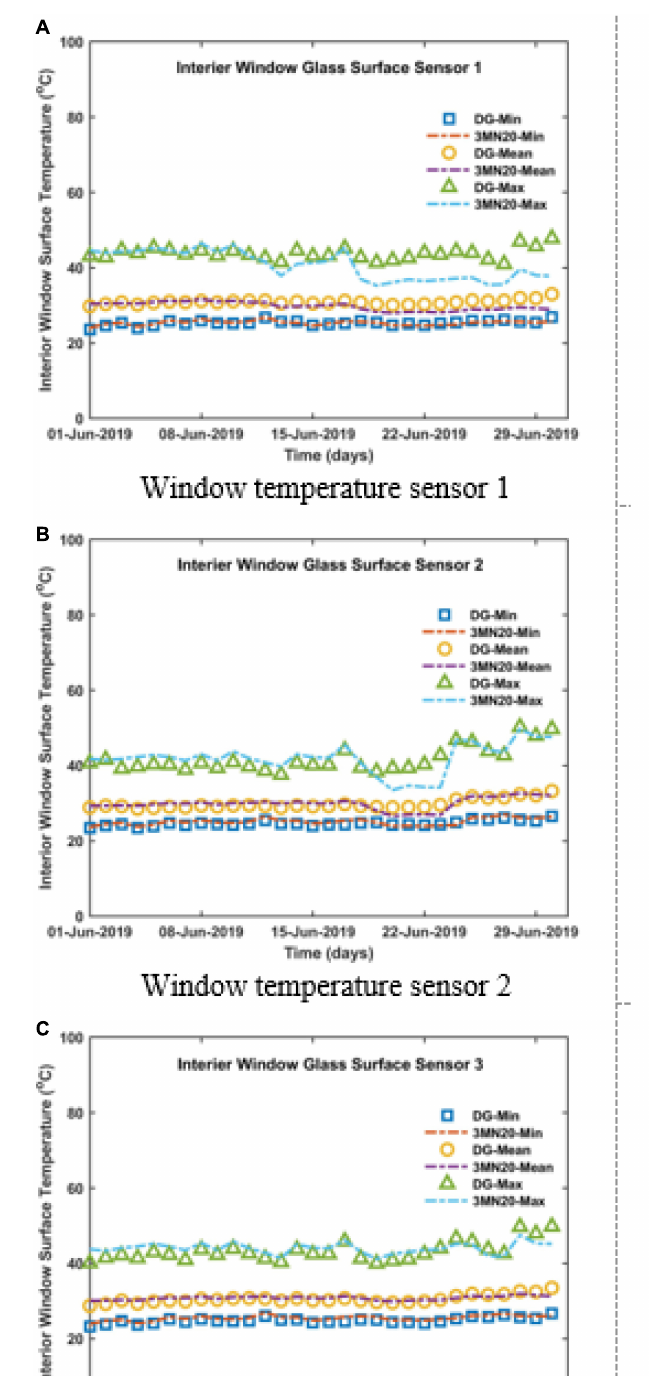
Frontiers in Energy Research |